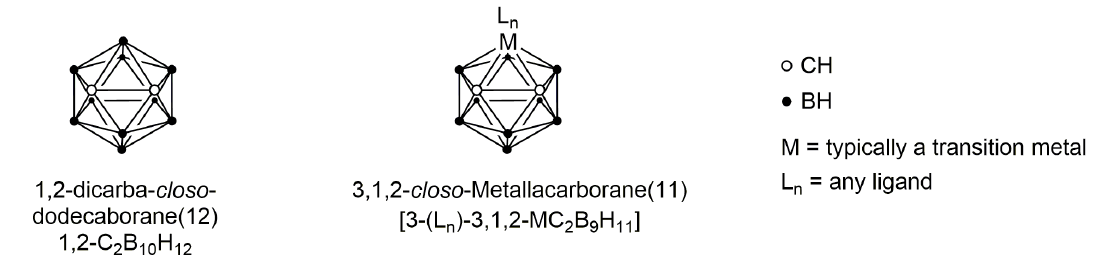
Figure 1. General structure of 1,2-dicarba- closo -dodecaborane(12) ( left ) and 3,1,2- closo -metallacarboranes(11) ( right ). Only one isomer per each structure is shown. For cluster nomenclature see Appendix